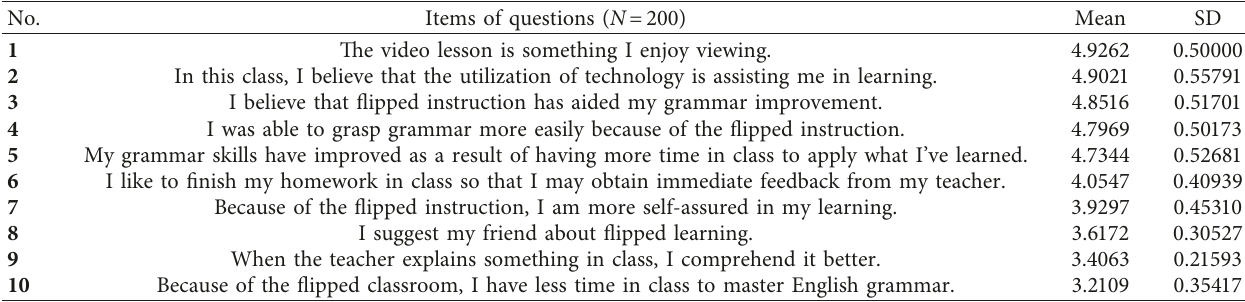
Table 2: Conceptions and viewpoints of the students regarding the flipped classroom method.